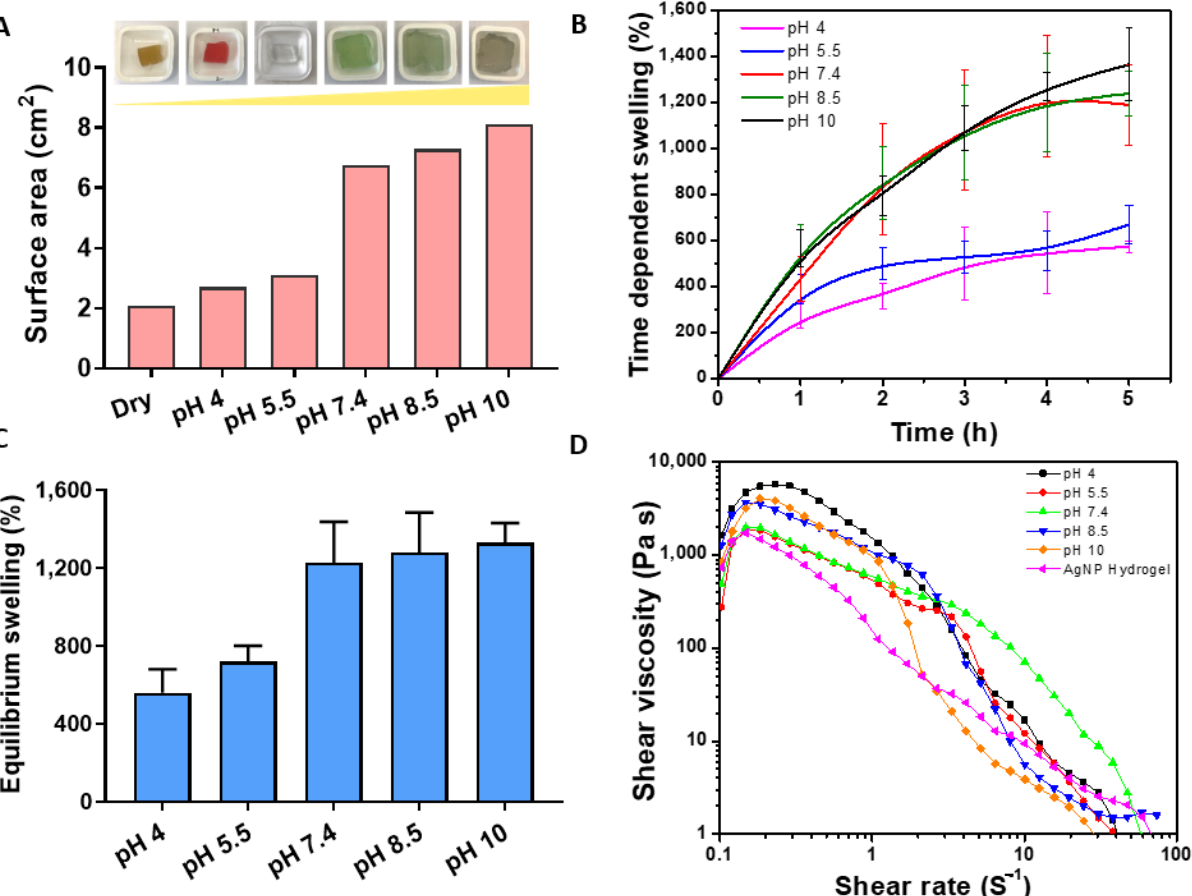
− Figure 2. ( A ) Change in surface area (cm 2 ) of the hydrogel in response to different pH (4–10) with the corresponding hydrogel photo after equilibrium swelling. The colors are due to the commercial pH buffer used. ( B ) Time dependence swelling kinetics after 5 h of swelling. ( C ) The difference in hydrogel swelling rate after reaching an equilibrium state. ( D ) Measurements of hydrogel mechanical properties measured by shear rate after equilibrium state.